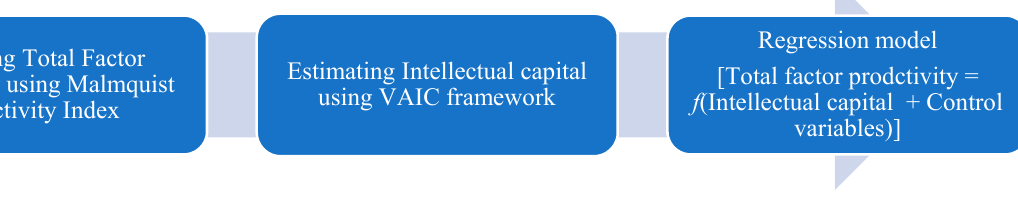
Figure 1. Research framework.Source: Author’s own compilation.